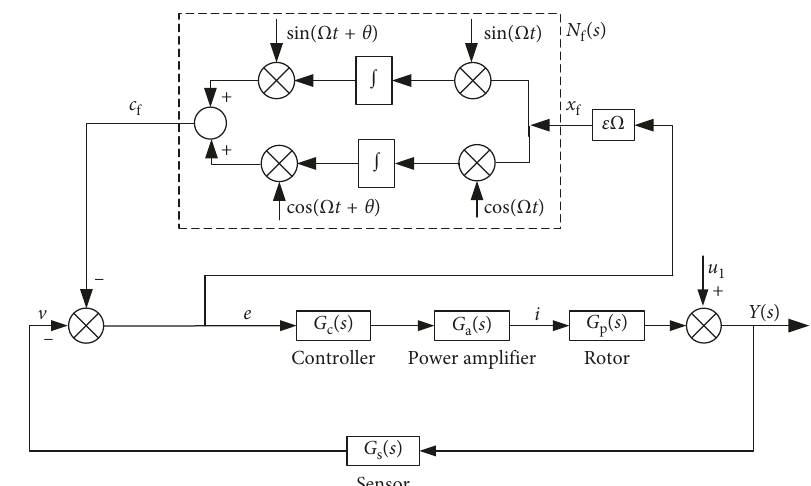
Figure 5: Unbalance control block diagram of the AMB-rotor system.